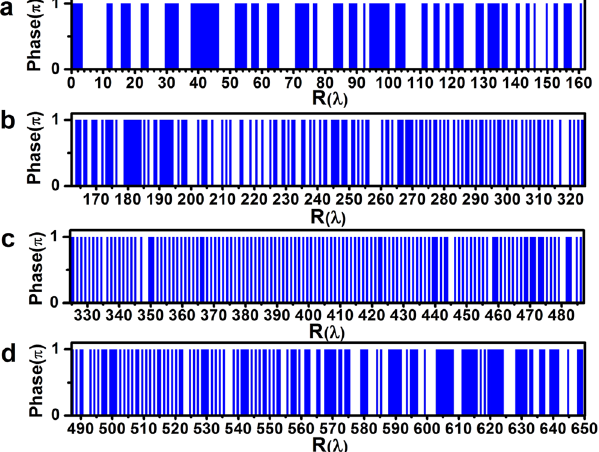
Figure 1. The optimized binary phase (i.e., 0 and π ) distribution of the super-oscillatory lens with radius of 650 λ for wavelength λ = 632.8 nm, where R is the radial coordinate and the rectangle blocks give the corresponding position and width of the 292 ring belts with phase of π . The ring belts located between two neighboring rectangle blocks have phase of 0.